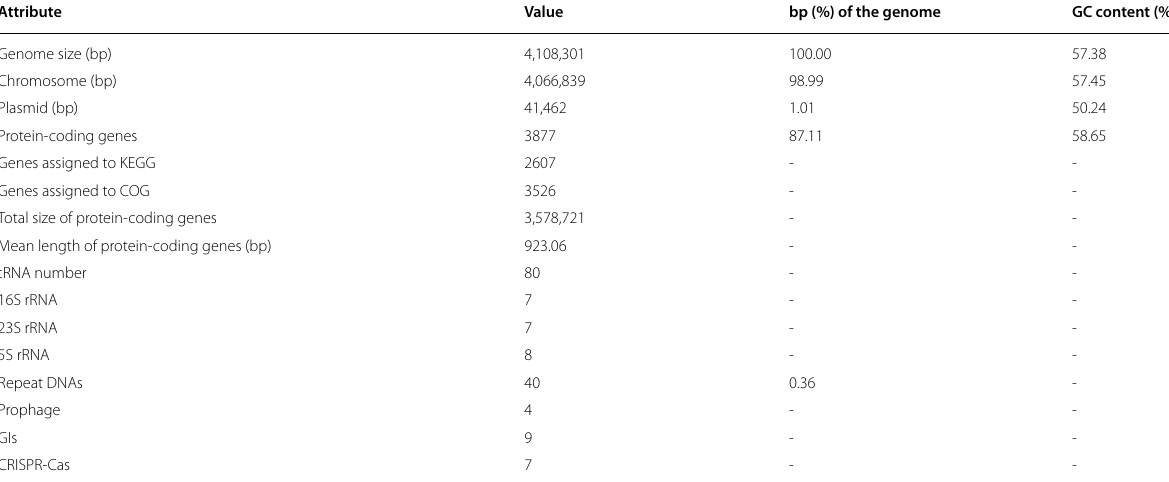
Table 3 General features of the mutant strain YSD YN2